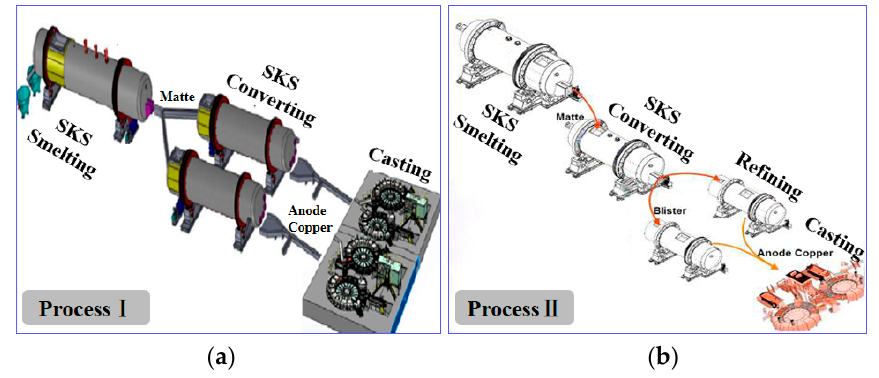
Figure 2. Schematic diagram of SKS smelting and converting process: ( a ) Fangyuan continuous converting process; ( b ) Yuguang continuous converting process.